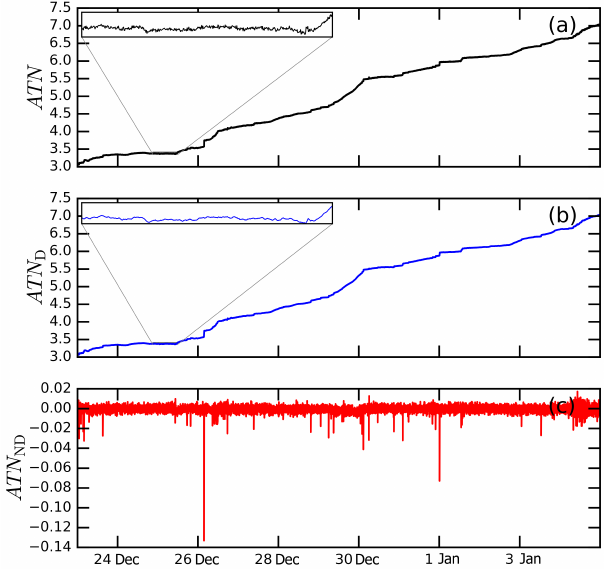
Figure 1. Decomposition of ATN from measurements of particle- free air at a wavelength of 520nm. Panel (a) shows the ATN values as reported by the instrument. Panel (b) shows the three-point run- ning mean which represents the drift in ATN (ATN D ) . Panel (c) shows the ATN-ATN D which is free of drift (ATN ND ) .